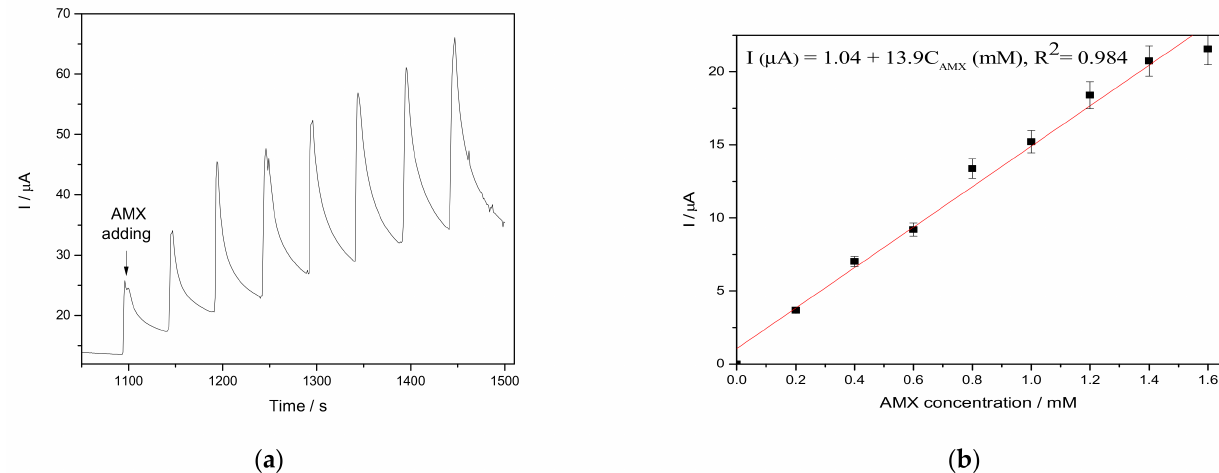
Figure 10. ( a ) Chronoamperograms recorded on CuBi/CNF electrode in 0.1 M Na 2 SO 4 supporting electrolyte and in the presence of various AMX concentrations: 0.2 mM, 0.4 mM, 0.6 mM, 0.8 mM, 1.0 mM, 1.2 mM, and 1.4 mM at ( a ) an applied potential level of +0.750 V/SCE. ( b ) Calibration plots for AMX detection in the concentration range of 0.2 to 1.4 mM.